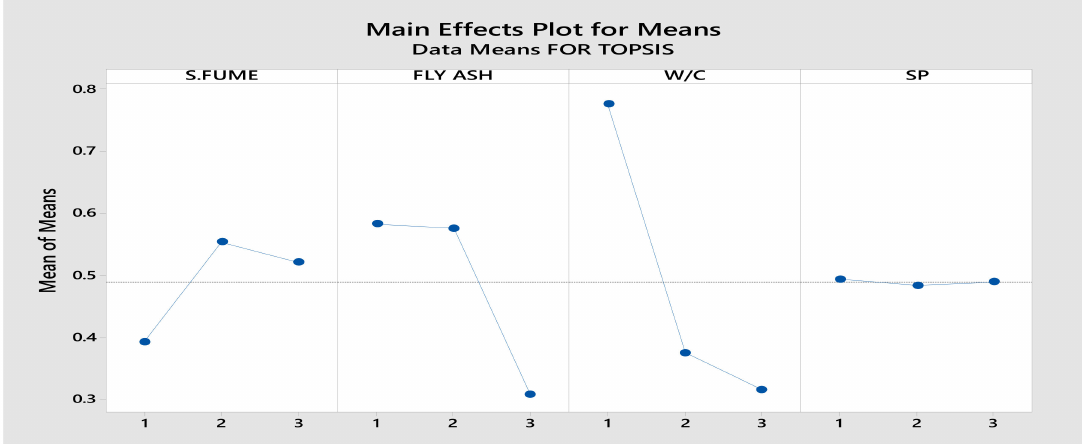
Figure 8. Graphs of parameter effects using